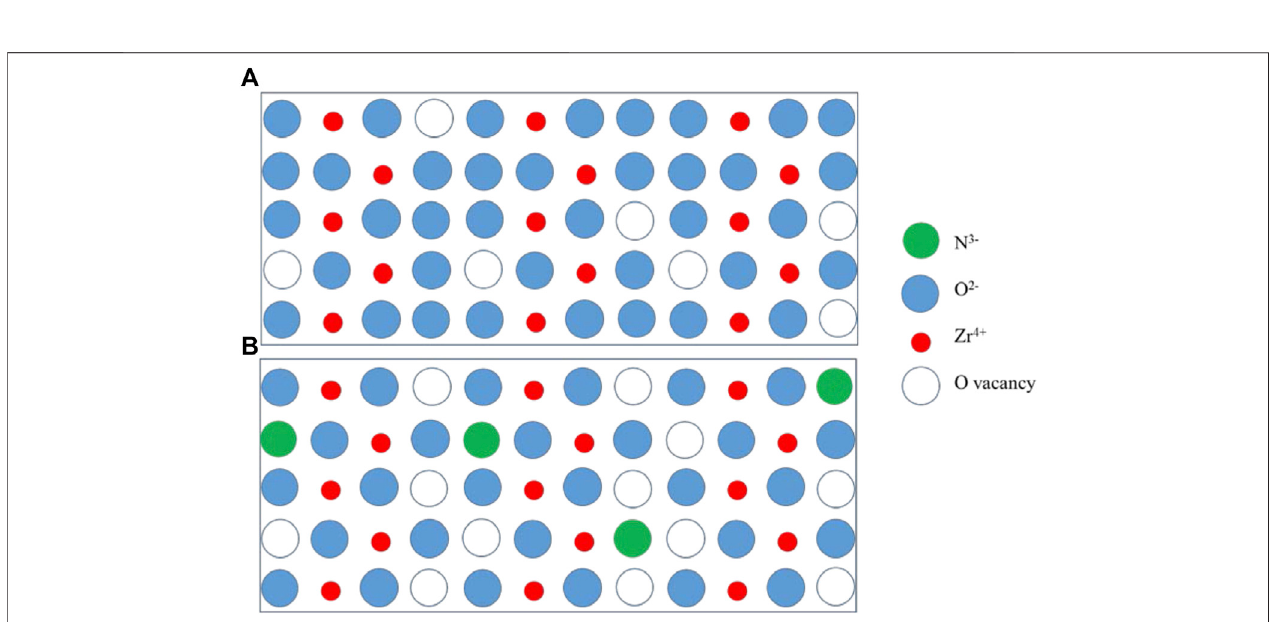
FIGURE 8 | Distributions of elements in oxide fi lms tested in (A) B – Li solution and (B) NH 4 OH solution along the depth direction.